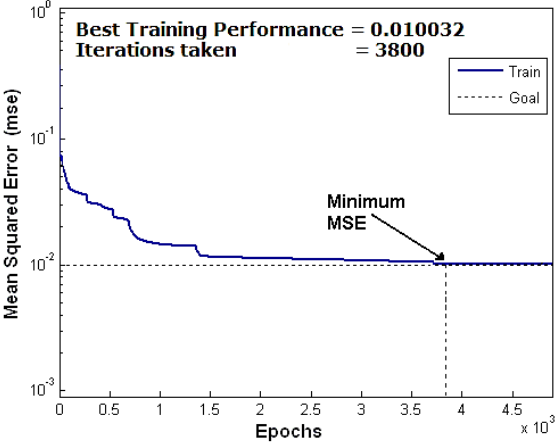
Figure 23. Variations occurred in MSE of the ANN during training pattern concerning an increase in the number of iterations.